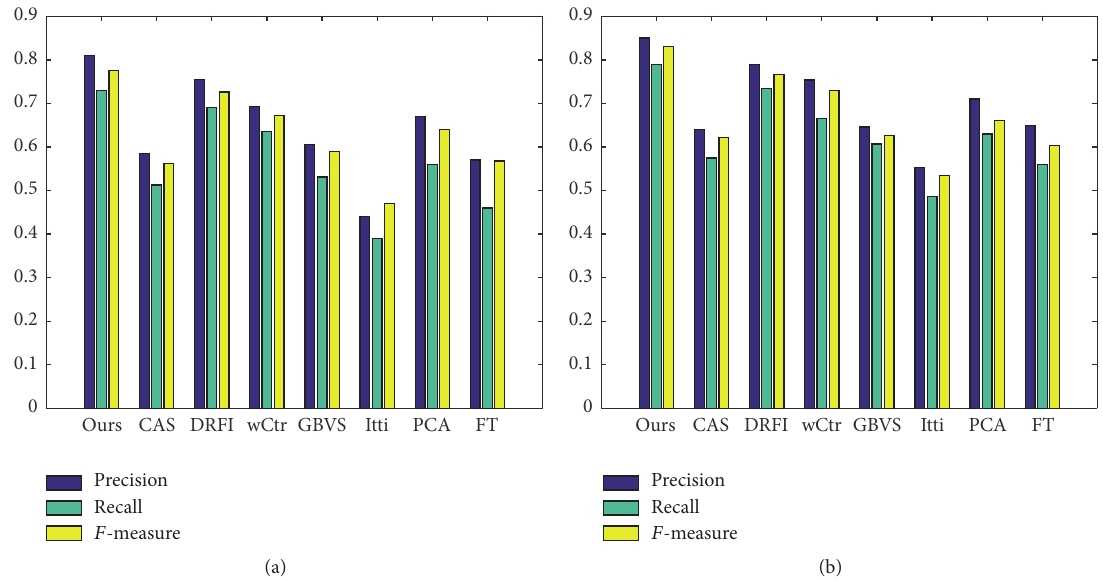
Figure 7: Precision, recall, and 𝐹 -measure for adaptive thresholds. (a) Measured on MSRA10K dataset. (b) Measured on ASD dataset.